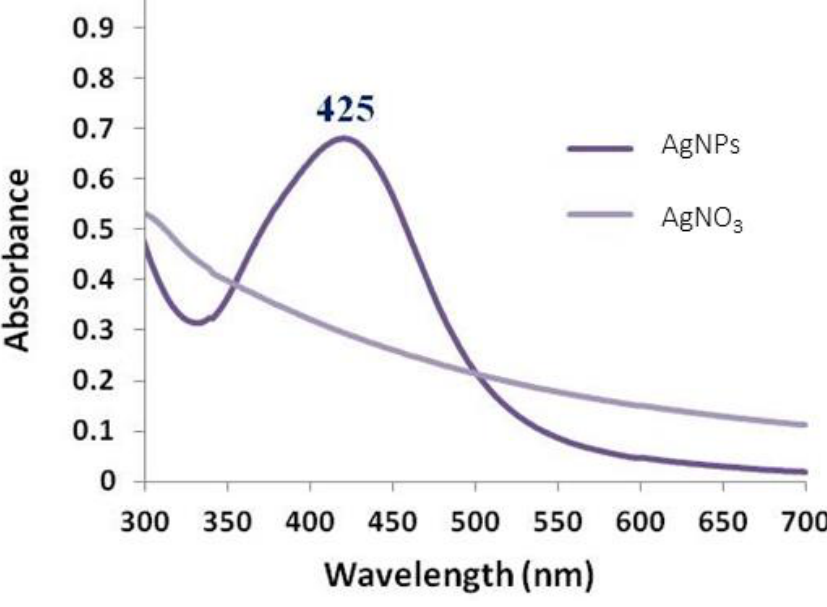
Figure 1. UV-visible spectroscopic analysis of biogenic AgNPs. The crystalline nature of biogenic AgNPs was analysed through XRD analysis. The results of the XRD spectrum revealed the presence of three distinct peaks representing Bragg reflections of 27.9 ◦ , 32.3 ◦ , 47.5 ◦ , 55.0 ◦ , 57.8 ◦ , 67.6 ◦ , 74.6 ◦ , 76.9 ◦ and 85.7 ◦ , relating to (1 1 1), (2 0 0), (2 2 0), (3 1 1), (2 2 2), (4 0 0), (3 3 1), (4 2 0) and (4 2 2) planes, respectively. These distinct peaks corresponding to the face-centered cubic (fcc) shape of the tested samples confirm the crystalline nature of the biogenic AgNPs (Figure 2), which was consistent with the database of the Joint Committee on Powder Diffraction Standards (JCPDS) (file No. 04-0783). The results of this study were supported by an earlier report [49] highlighting that the XRD spectrum of silver chloride nanoparticles displays solid peaks at 2 θ values of 27.9 ◦ , 32.3 ◦ , 46.3 ◦ , 55.0 ◦ , 57.6 ◦ , 67.6 ◦ , 74.6 ◦ , 76.9 ◦ and 85.7 ◦ , relating to (1 1 1), (2 0 0), (2 2 0), (3 1 1), (2 2 2), (4 0 0), (3 3 1), (4 2 0) and (4 2 2) planes, respectively. The size and shape of the biogenic AgNPs were determined using TEM analysis. The TEM analysis revealed the presence of AgNPs, which were globular in structure with an median size varying from 20 to 60 nm; in addition, the presence of silver peaks in the EDX spectrum confirms the formation of AgNPs (Figure 3a,b). The surface properties of the synthesized biogenic AgNPs were analysed using an atomic force microscope. The results showed a three- dimensional morphology of the synthesized AgNPs having a particle size of approximately 40 nm, with a spherical shape (Figure